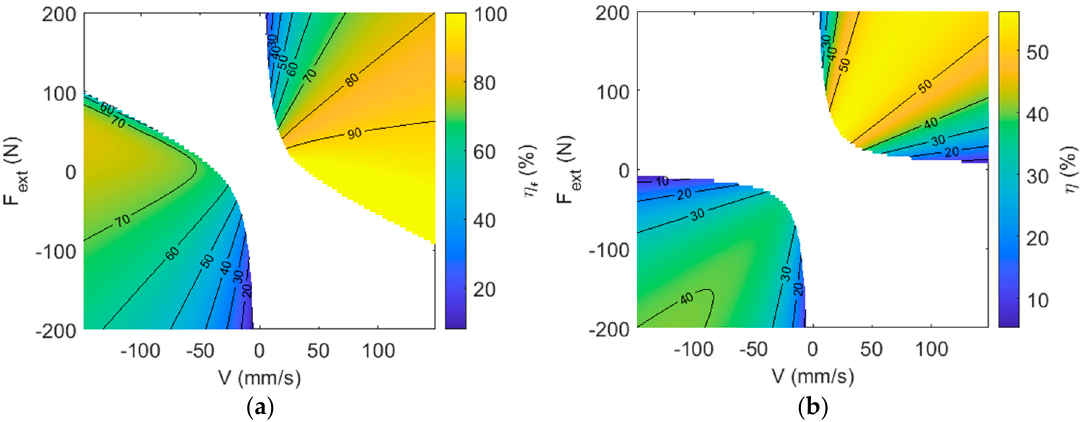
Figure 11. Fluid ( a ) and overall ( b ) efficiencies for Valve B system (the Valve A system is similar). Only areas for positive pump output power are shown for clarity. Note that the overall efficiency does not include the pumps’ frictional losses.